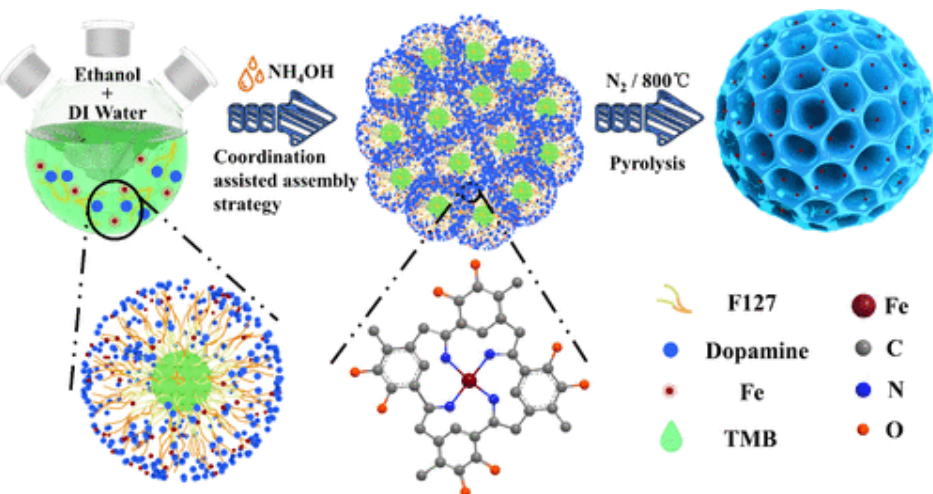
Figure 2. The preparation procedure of meso-Fe-N-C catalysts. Reprinted with permission from Ref. [10]. Copyright © American Chemical Society 2021.